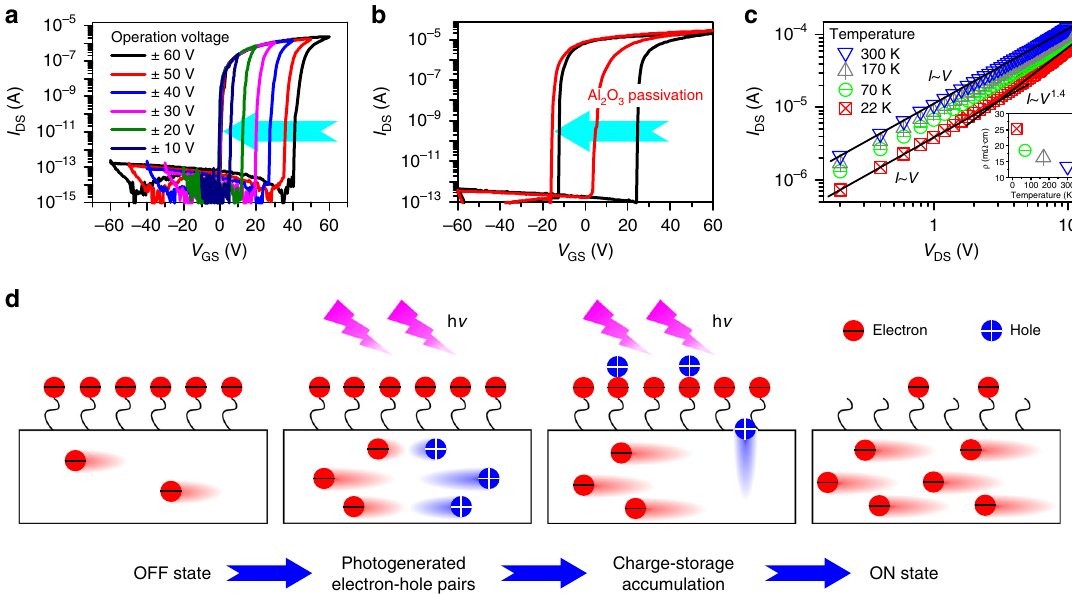
Fig. 2 Mechanism analysis of optical memory characteristics of CdS NR-based phototransistor. a Electrical transfer characteristics of the CdS NR phototransistor measured at different gate voltages from ± 10 to ± 60 V. b Electrical transfer characteristics of the CdS NR phototransistor measured before and after Al 2 O 3 passivation. c I DS − V DS curves of the CdS NR phototransistor plotted in a double logarithmic scale at different temperatures. The inset shows the resistivity ρ of the CdS NR at different temperatures. The electrical transfer characteristics in a and b as well as the I − V curves in c were measured in the dark after light pre-irradiation for 10 s (190nW cm − 2 ). d Schematic illustration of the optical memory process in the CdS